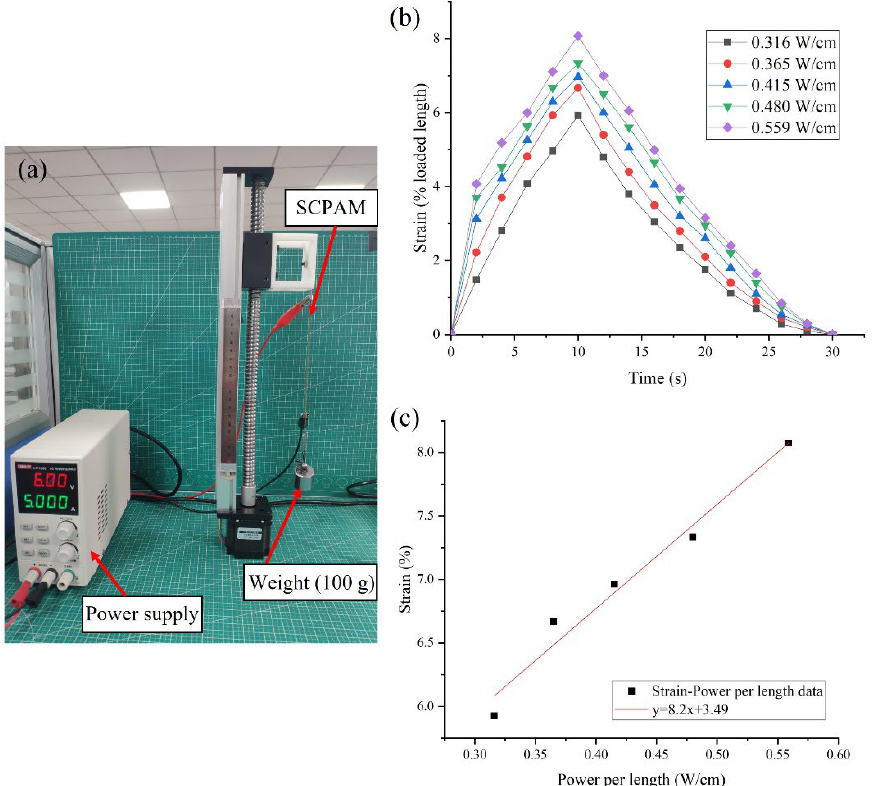
Figure 6. Strain characterization of the SCPAM. ( a ) Test platform. ( b ) Strain–time curves under different power per length conditions. ( c ) Relationship between the maximum strain and power per length.